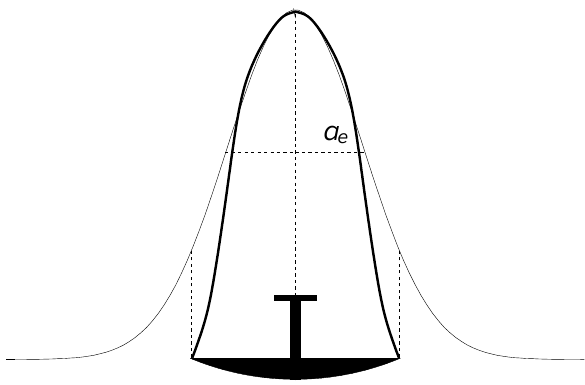
transmitandre eivingantennas.